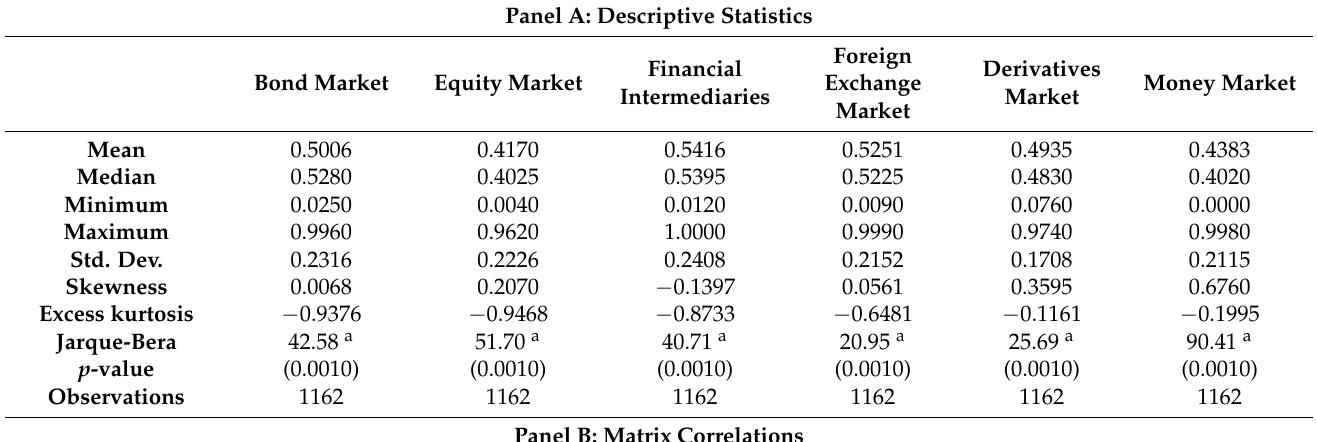
Table 2. Descriptive statistics and contemporaneous correlations of the stress indices. Panel A: Descriptive